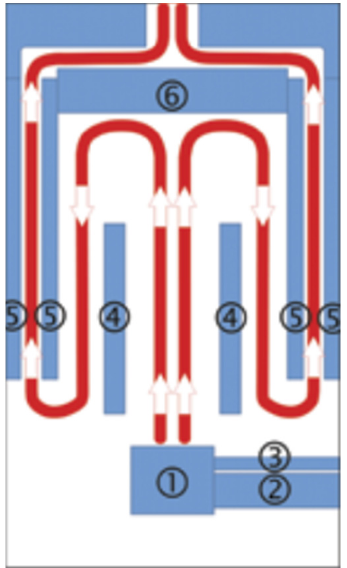
Figure 3. Scheme of the combustion chamber structure in cross section with flue gas flow: 1—burner, 2—pelet feeder, 3—aeration pipe, 4—partition, 5—water jacket, 6—exhaust deflector (location of the